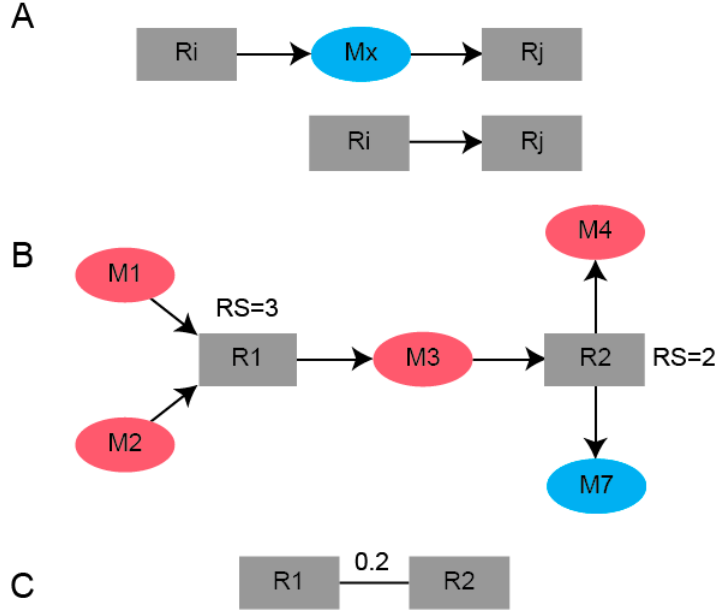
Figure 5. Schematic of the conversion of a ( A ) bipartite graph using ( B ) reaction scores computed from the number of SSMs either produced or consumed for a given reaction to a ( C ) weighted reaction-centric graph.